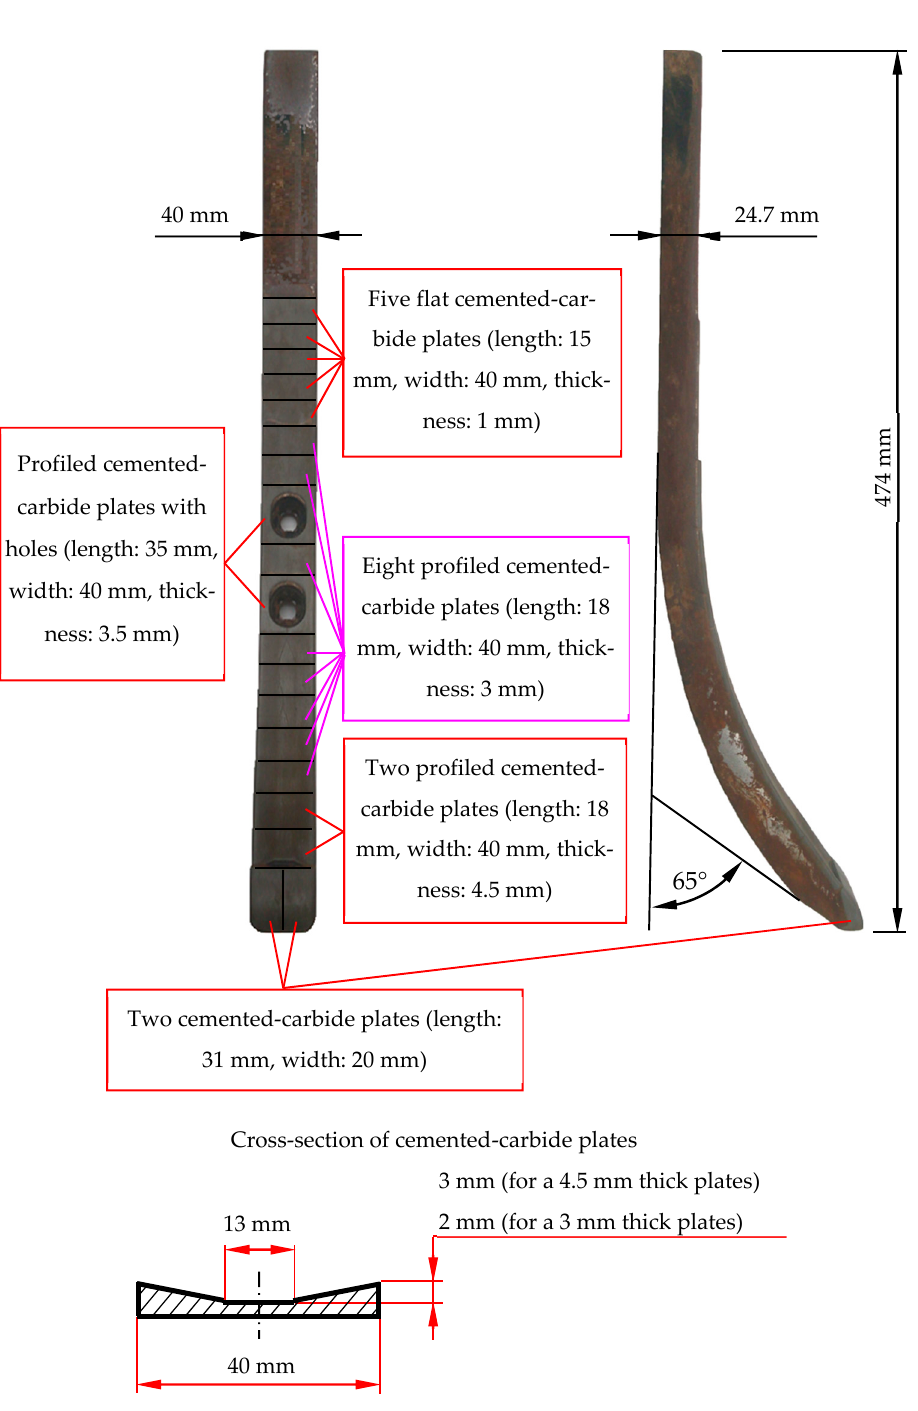
Figure 1. Tested chisels: variant A.